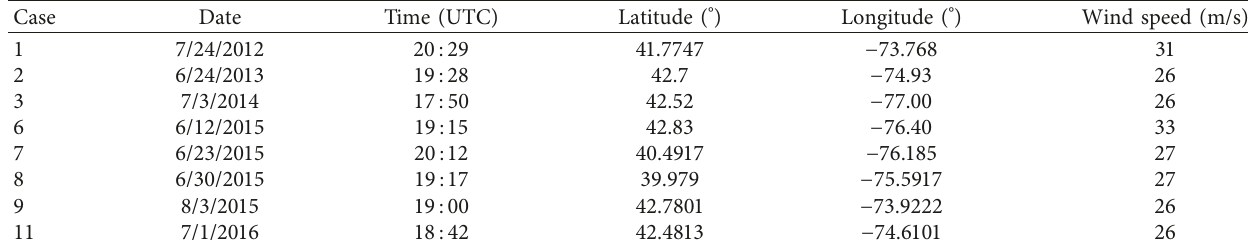
Figure 2: Terrain map of the eleven quasi-cellular microburst storm tracks (lines) and locations (circles) and the eight quasi-cellular null event storm tracks (lines) and locations (triangles). Table 2: List of null severe wind events examined in this